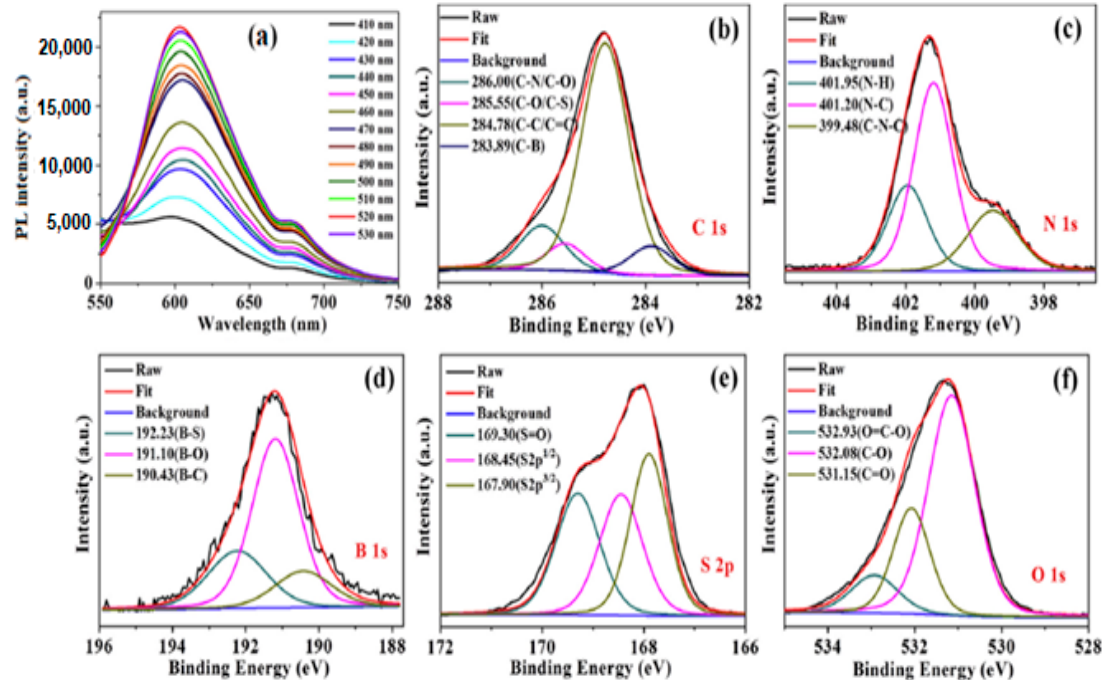
Figure 3. ( a ) PL spectra of NBS-C-dots with λ ex ranging from 410 nm to 530 nm. C 1s ( b ), N 1s ( c ), B 1s ( d ), S 2p ( e ), and O 1s XPS spectrum ( f ) of NBS-C-dots. Reprinted (adapted) with permission from [44]. Copyright 2021